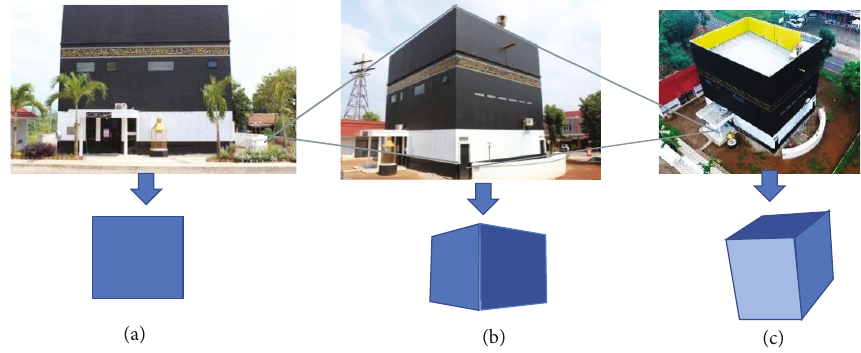
Figure 14: Cubic simple house diagram: (a) one vanishing point, (b) two vanishing points, and (c) three vanishing points.